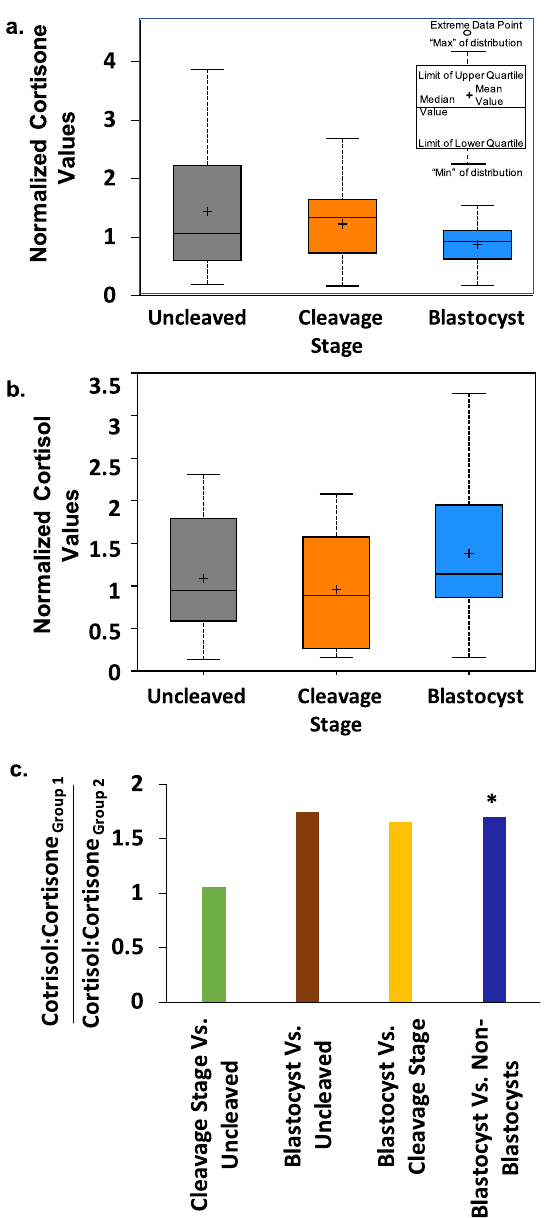
Figure 3. Glucocorticoid levels in FF are indicative of oocyte competency. Box plots depicting the normalized values of ( a ) cortisone and ( b ) cortisol in the FF of each corresponding embryo group. ( c ) The ratio of cortisol to cortisone in the FF shown by a pairwise comparison between the embryo groups. Note that the cortisol to cortisone ratio is significantly higher in the FF of the blastocyst versus non-blastocyst groups (*; p =